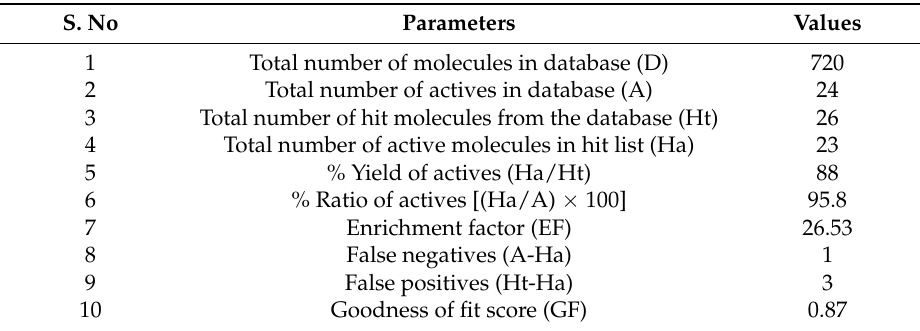
Figure 2. Validation of the selected pharmacophore model by receiver operating characteristic (ROC) curve. Table 2. Different parameters computed through decoy set method .